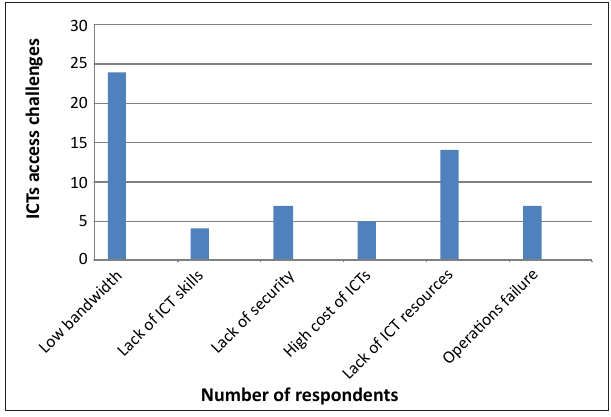
FIGURE 3: Challenges in accessing information and communication technology (ICTs). The majority of respondents indicated that they would prefer to automate their daily routines with the use of